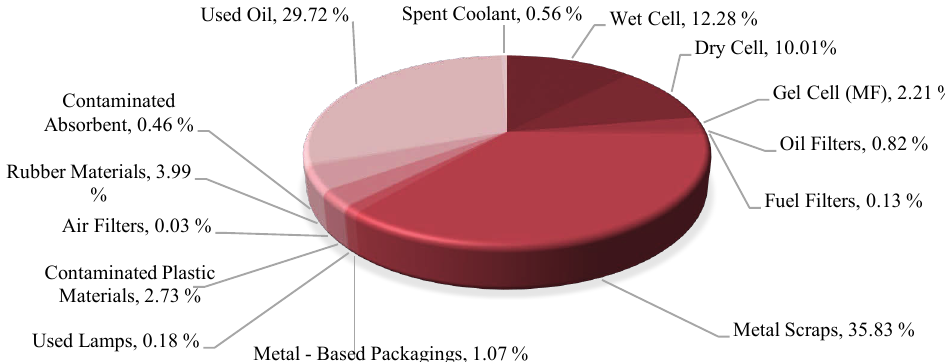
Fig. 3. Waste composition in unlicensed